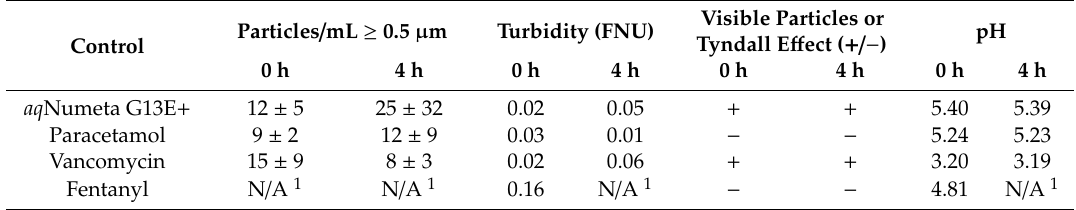
Table 5. Physico-chemical characteristics of unmixed controls of aq Numeta G13E + and drugs (average values ± SD, n = 3).